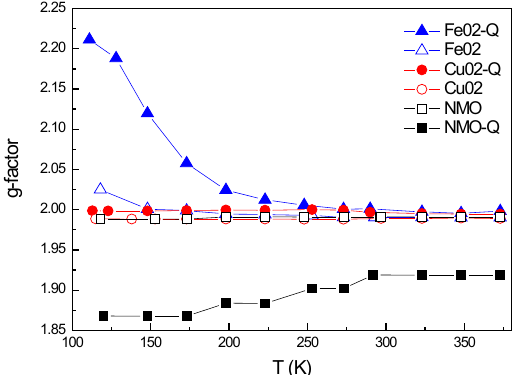
Figure 6. The g-factor as a function of temperature for all the samples.